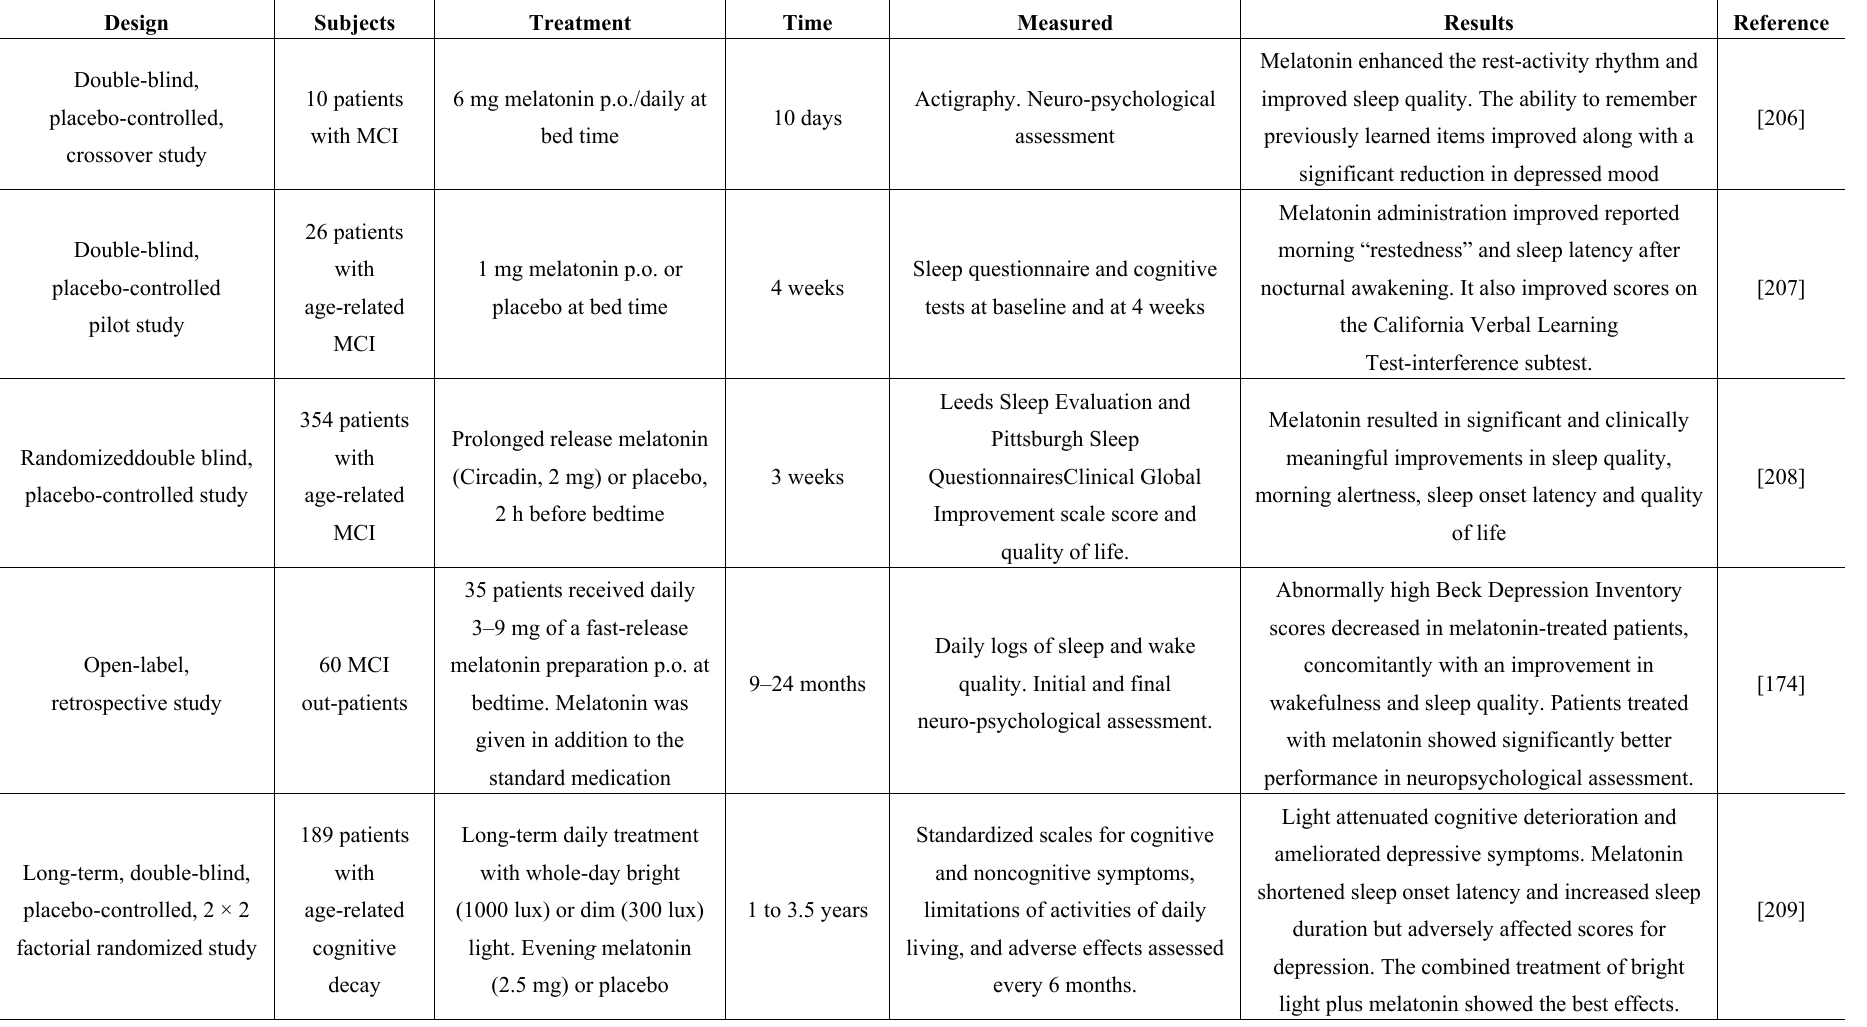
Table 2. Studies including treatment of mild cognitive impairment (MCI) patients with